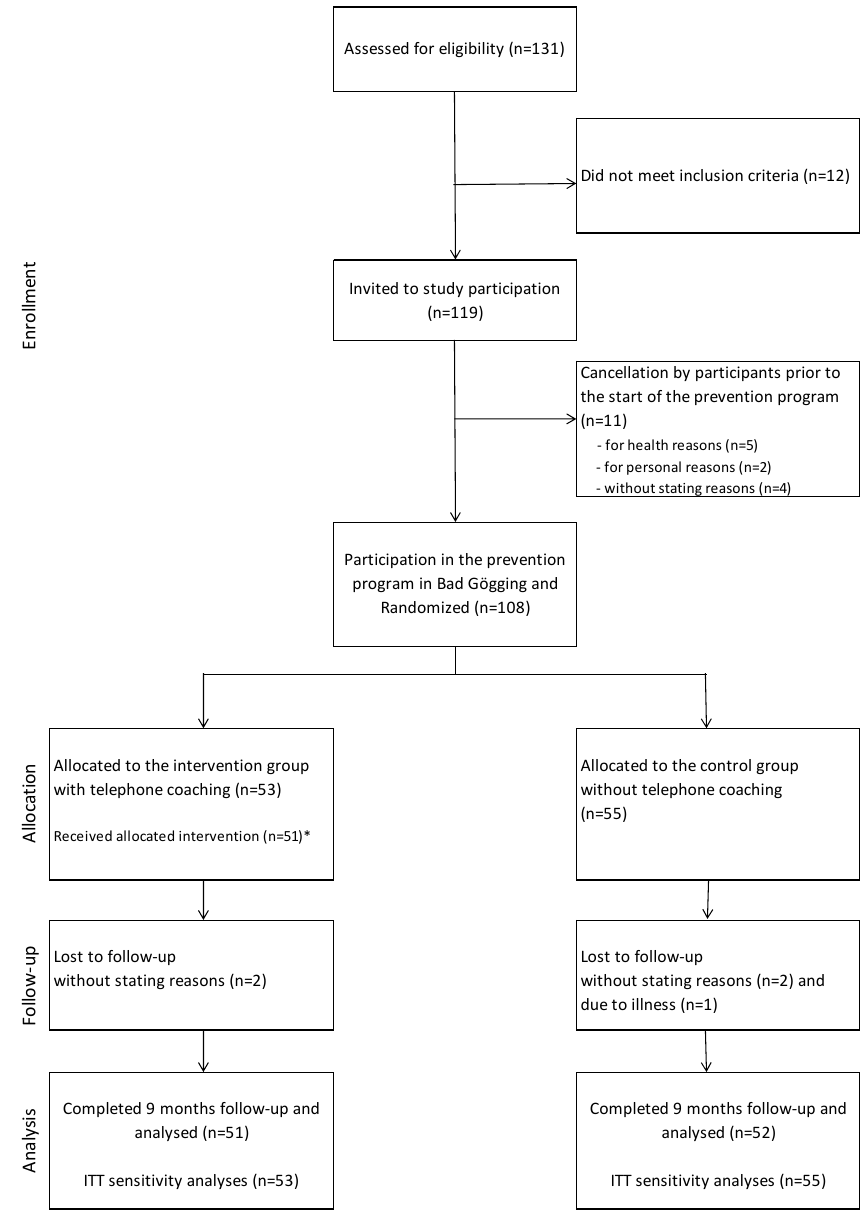
Figure 1. Participant flow.